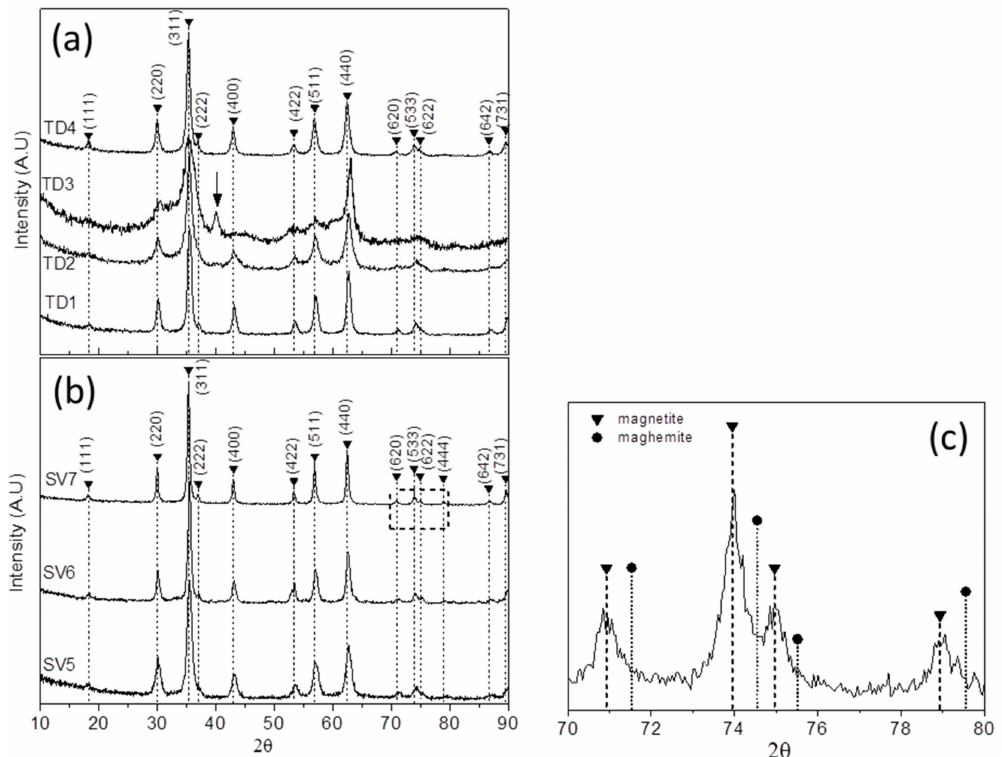
Figure 4. The XRD patterns of ( a ) the thermal decomposition samples TD1, TD2, TD3, TD4 and ( b ) the solvothermal samples SV5, SV6, and SV7. The dominant phase in all samples is magnetite. ( c ) An enlarged area of the Figure 4b from 70 ◦ to 80 ◦ certifies that the solvothermally synthesized samples consist almost exclusively of